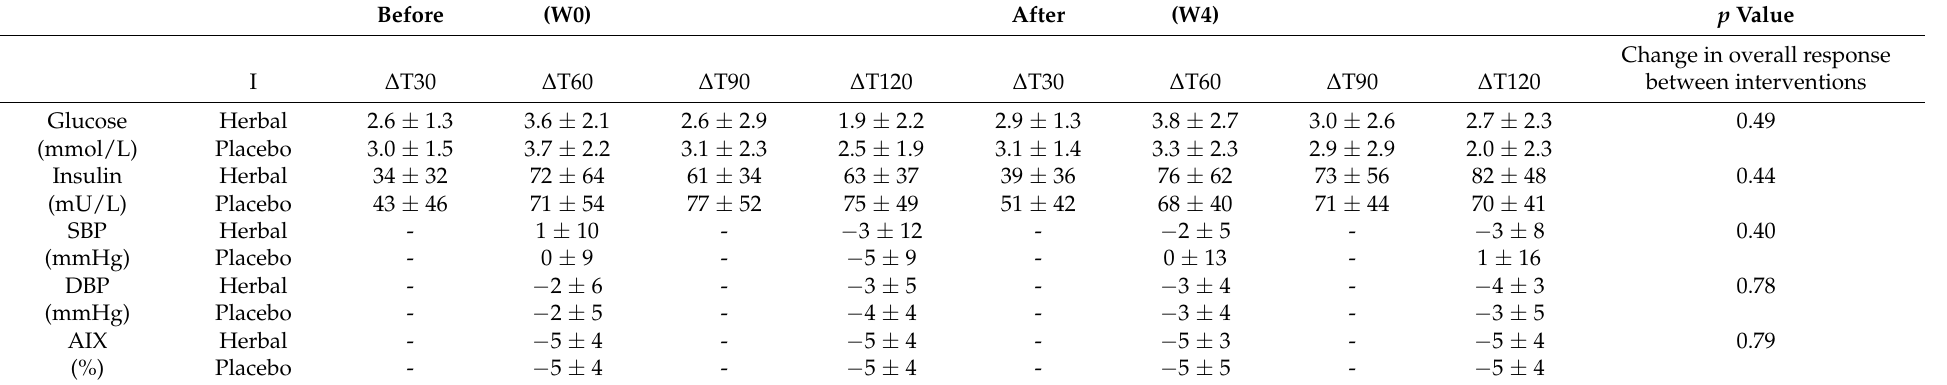
Values are mean ± SD, delta values are compared to baseline (T0), n = 19 for glucose and Insulin, n= 18 for SBP and DBP and n = 15 for AIX. P values of the change in response between interventions were calculated by using linear mixed models for repeated measures on delta values (week4–week0) for each postprandial time point by using the interaction “intervention*postprandial time point” as a fixed